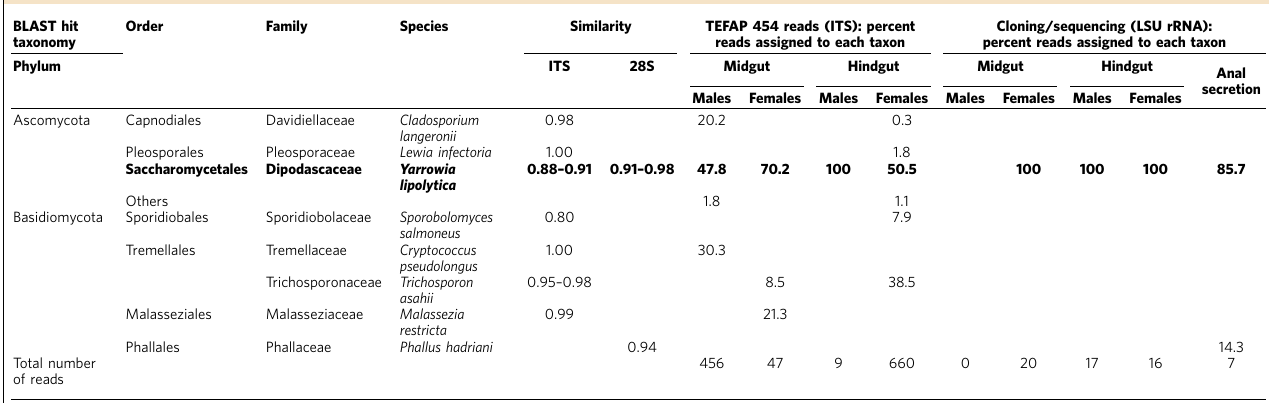
Cloning/sequencing (LSU rRNA): reads assigned to each taxon percent reads assigned to each